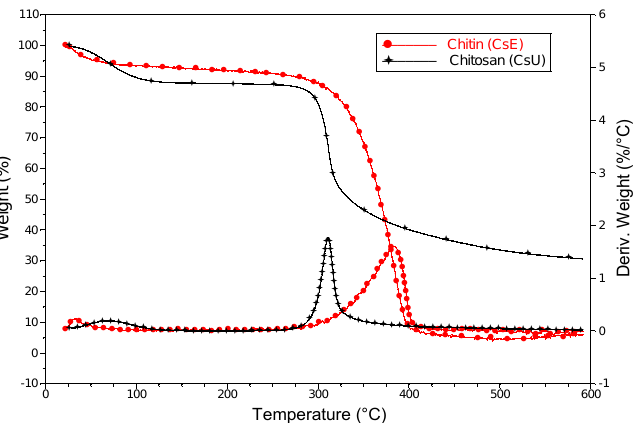
Figure 9. TGA analysis of electrospun CsU1 mat before (black) and after (red) reacetylation.